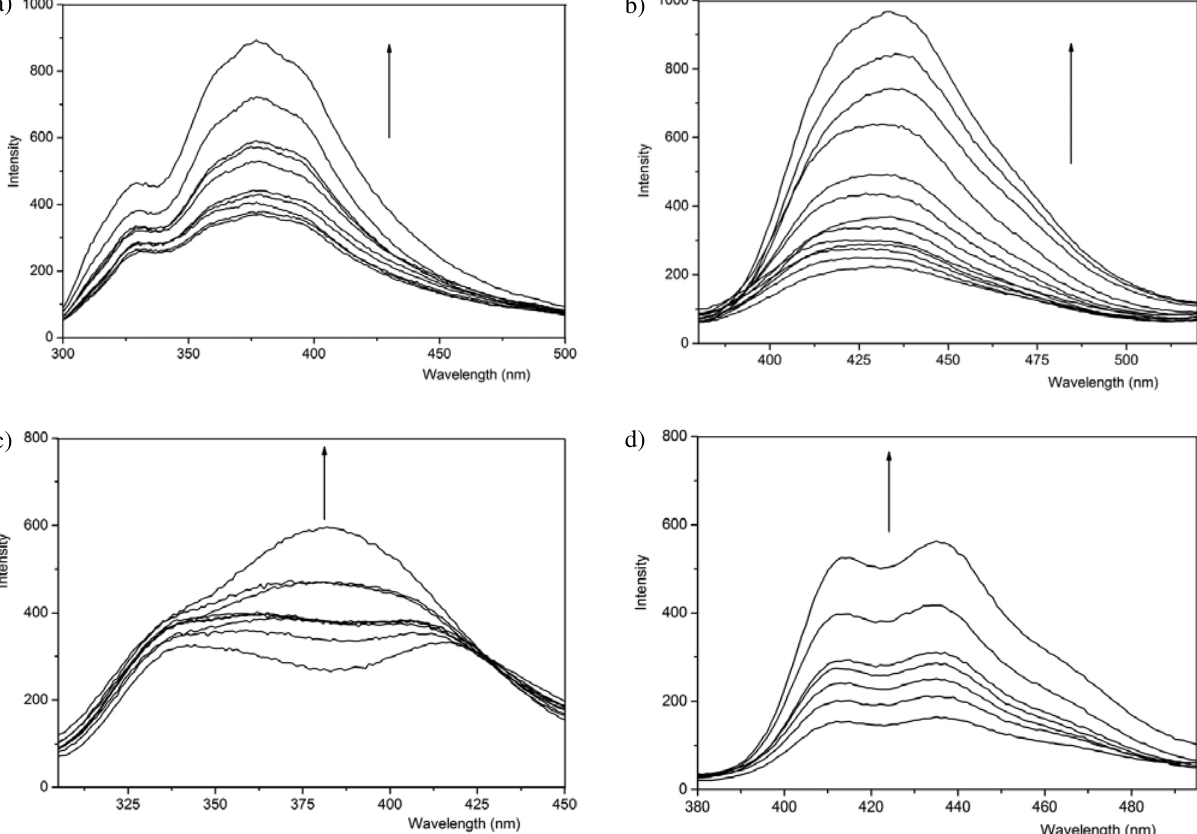
Fig. 5. Changes in the emission spectra of compounds (4.0 × 10 –5 mol·L –1 ) in absence and presence of AcO – (0 ∼ 80 × 10 –5 mol·L –1 ), a) compound 1 , λ